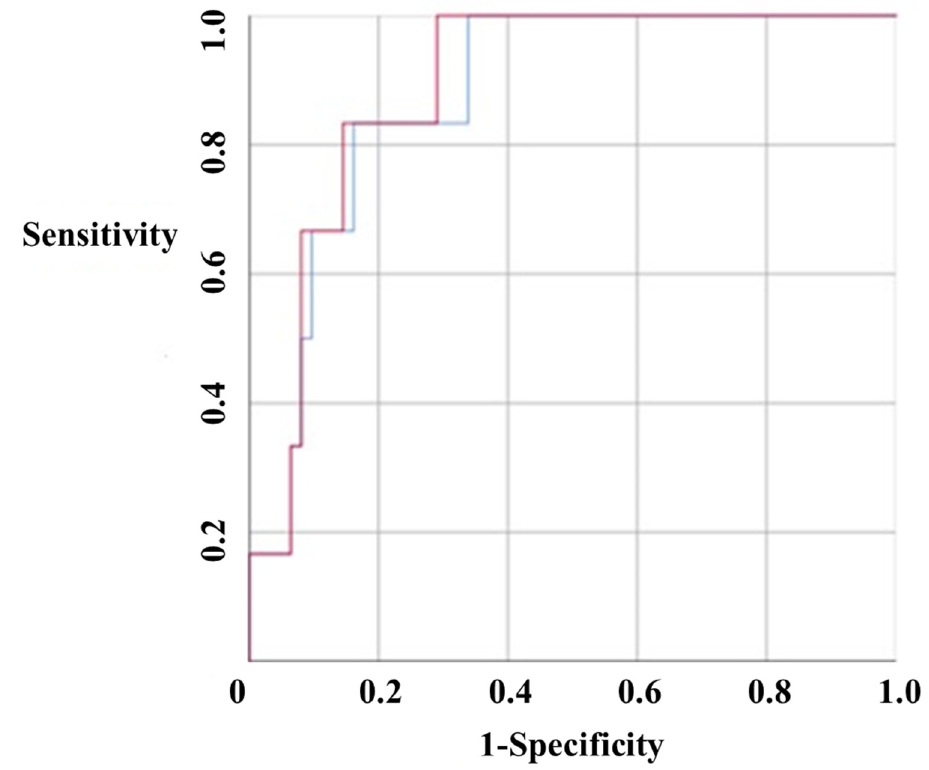
Figure 1. Receiver operating characteristic (ROC) curve. The tumor long axis was found to have an area under the curve (AUC) of 0.876 (red color, 95% CI 0.771–0.982), and the volume was found to have an AUC of 0.89 (blue color, 95% CI 0.796–0.984). These values were not significantly different, but the positive predictive value of tumor volume was slightly higher than that of tumor long axis.